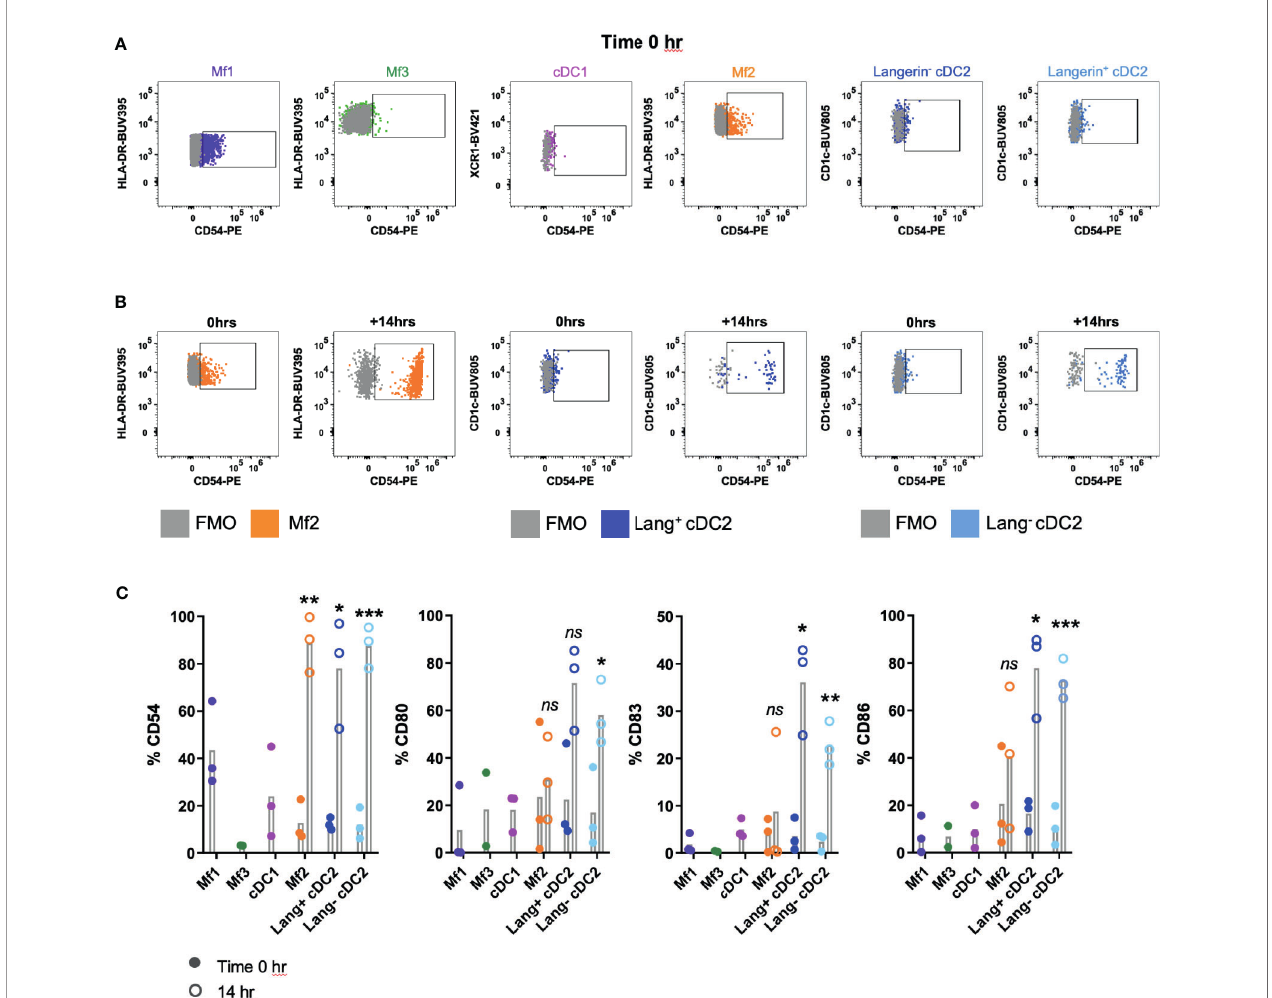
FIGURE 5 | Investigating the maturation phenotype of tissue MNPs liberated by enzymatic digestion. Intestinal mononuclear phagocytes (MNP) were isolated as per Figure 1 . Cells were stained for fl ow cytometry with FACSymphony Phenotyping Panel ( Table 1 ) with drop-ins for CD54, CD80, CD83 and CD86, immediately following liberation (time 0 hr) as well as 14 hr post-liberation. (A) Cells were gated as per Figure 4A , with representative plots of time 0 hr expression of CD54 shown, compared to Fluorescence Minus One (FMO). (B) Representative plot for Mf2, langerin + cDC2 and langerin - cDC2 showing expression of CD54 at time 0 hr compared to 14 hr post-liberation, compared to FMO. (C) Expression of CD54, CD80, CD83 and CD86 on MNP subsets at time of liberation (closed circles), with 14-hr comparison (open circles) for Mf2, langerin + cDC2 and langerin - cDC2 (n=3). Statistics was by a paired Student ’ s t-test comparing each marker for each cell type at 0h with 14h (*p < 0.05, **p < 0.01, ***p < 0.001, ns, not signi fi